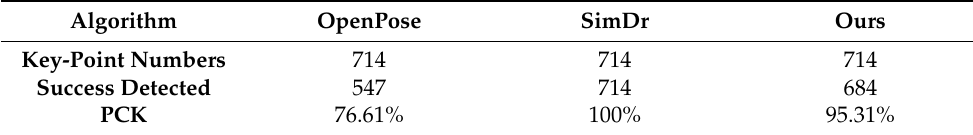
Table 3. The success detected number and PCK of different algorithms.